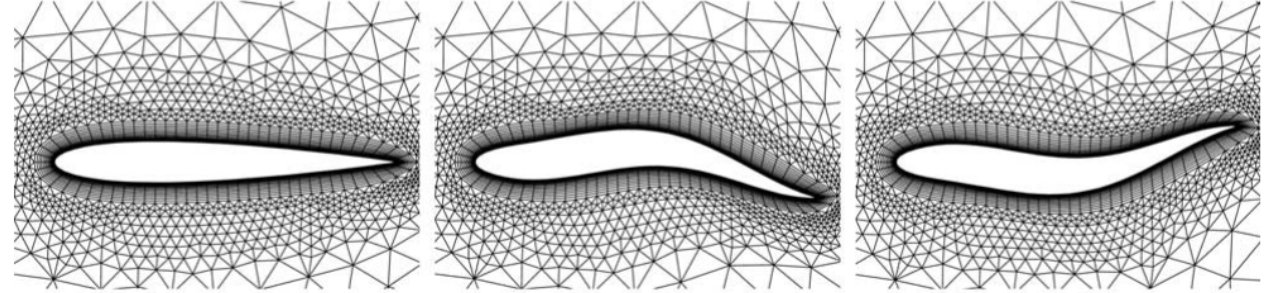
Figure 12. Original and moved meshes, Adapt with permission from [96].